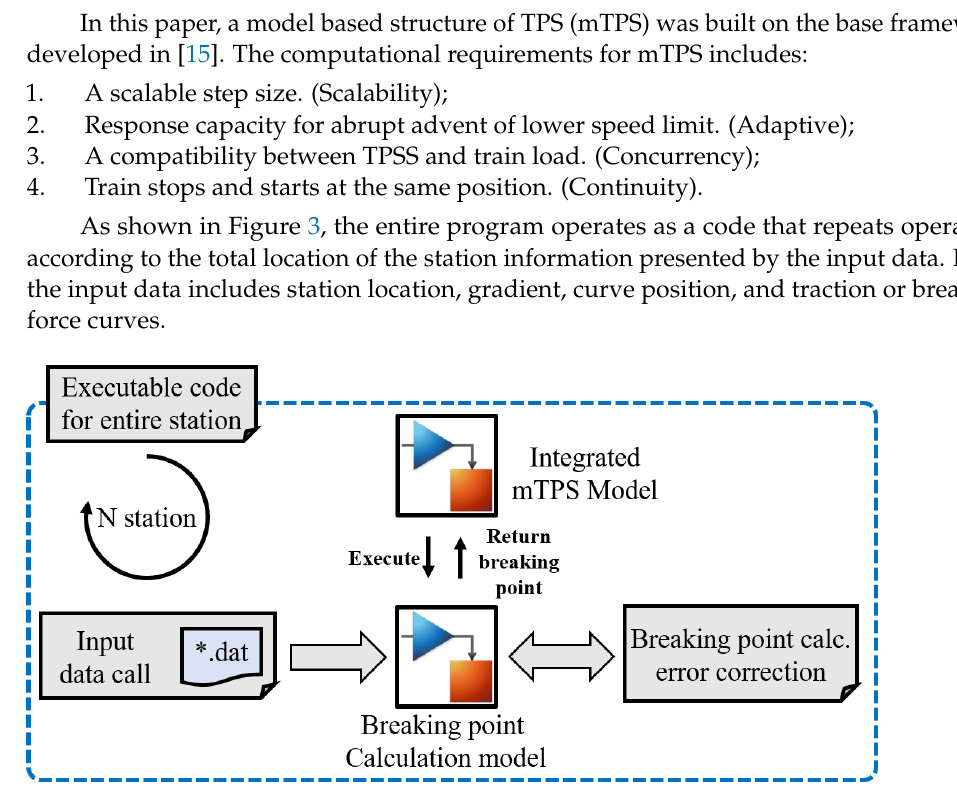
Figure 3. Computational procedure of mTPS.